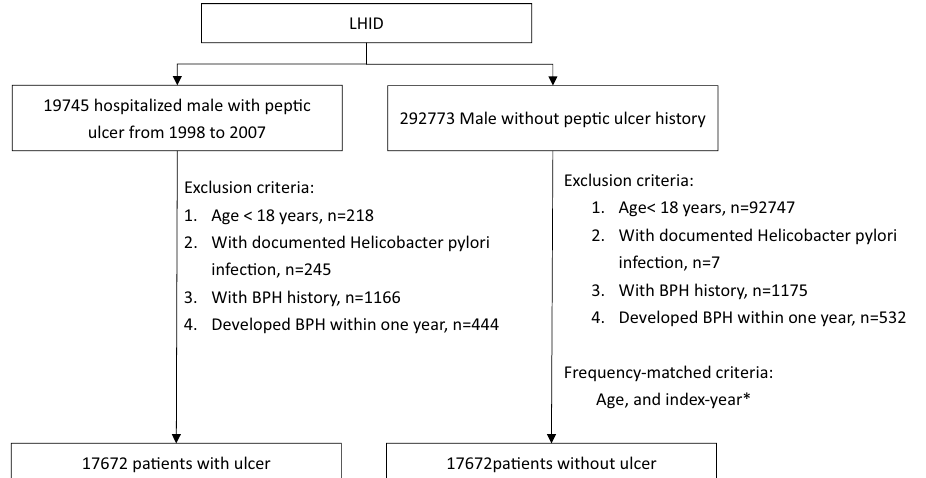
Figure 1. Flow chart for selecting study cohorts. *Randomly assigned entry date as ulcer admission